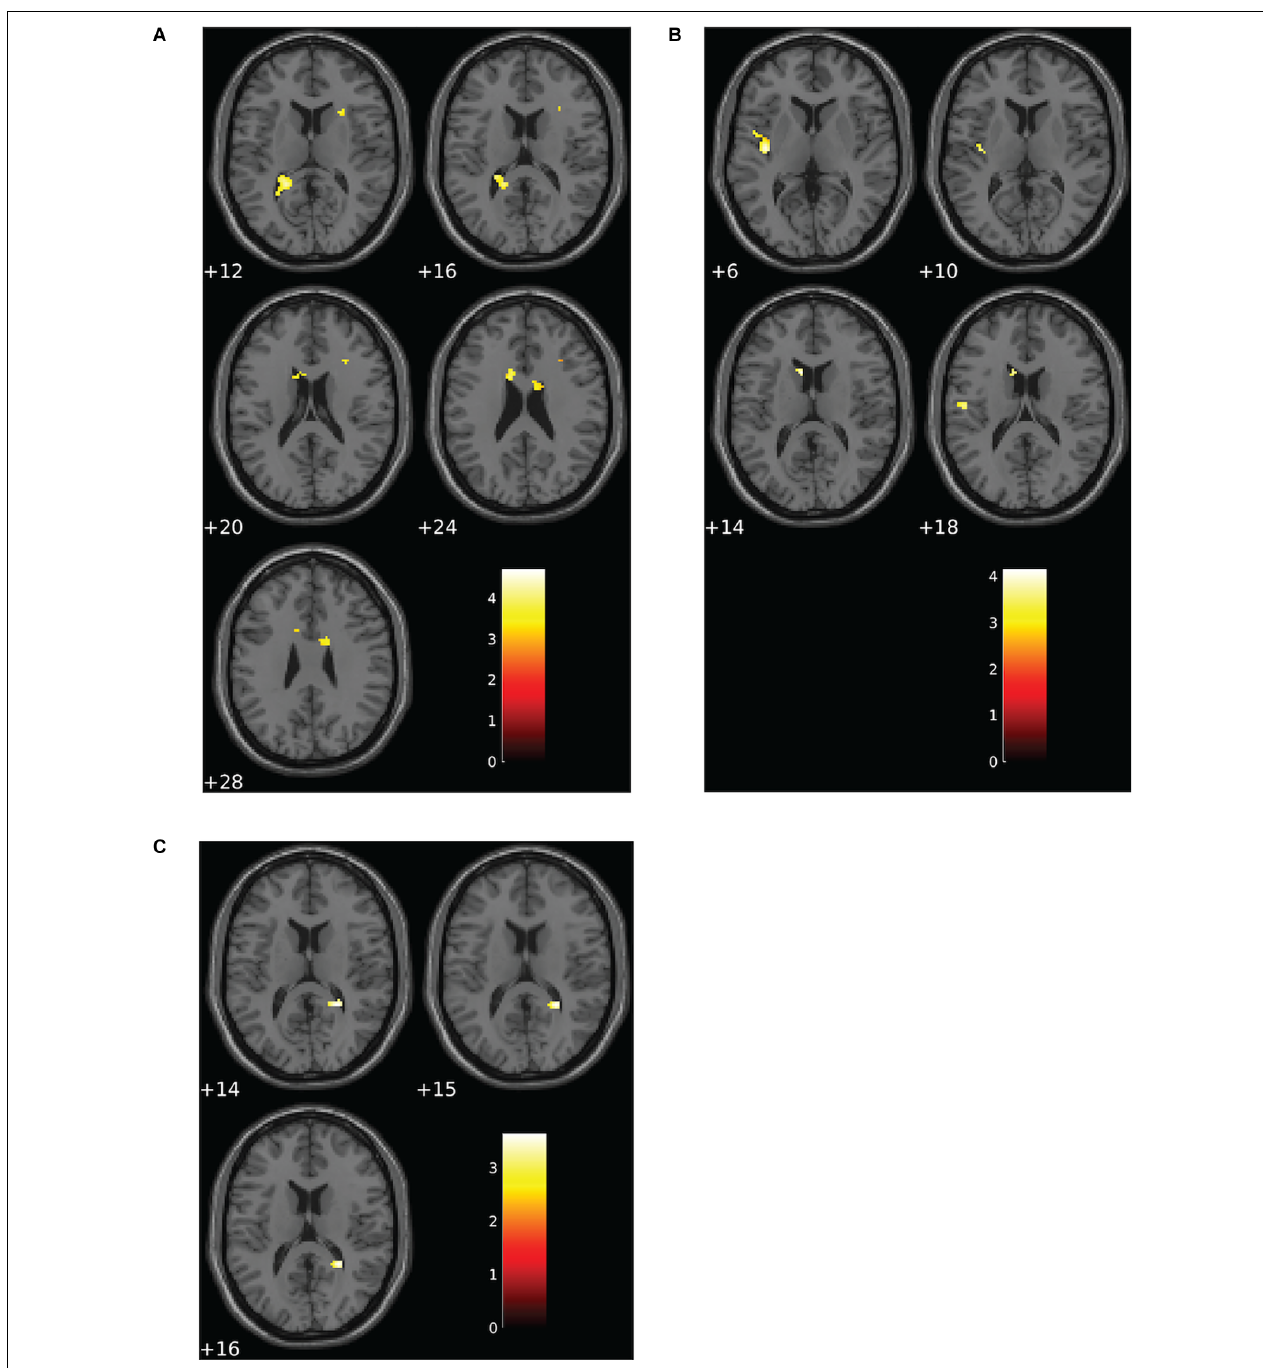
FIGURE 3 | Group differences for patterns of BOLD signal for the verbal N-back task. (A) The choking group exhibited increased activation compared to the choking-naïve group for the contrast between the 1-back and 0-back conditions. (B) For the contrast between the 2-back and 0-back conditions, the choking group exhibited increased activation compared to the choking-naïve group. (C) For the contrast between the 2-back and 1-back conditions, the choking-naïve group had increased activation in one cluster relative to the choking group. Statistical non-parametric maps were thresholded at p = 0.001 (uncorrected) and k ≥ 20.